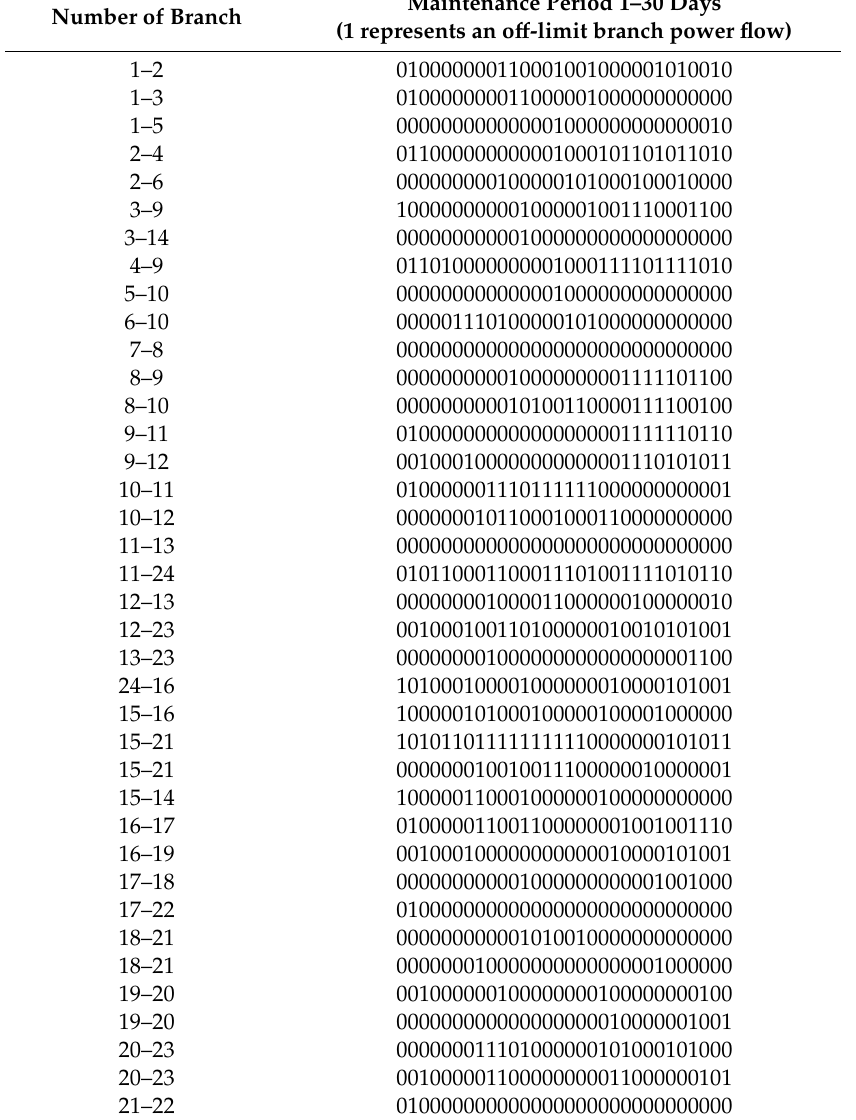
Table A7. Solution B o ff -limit branch power